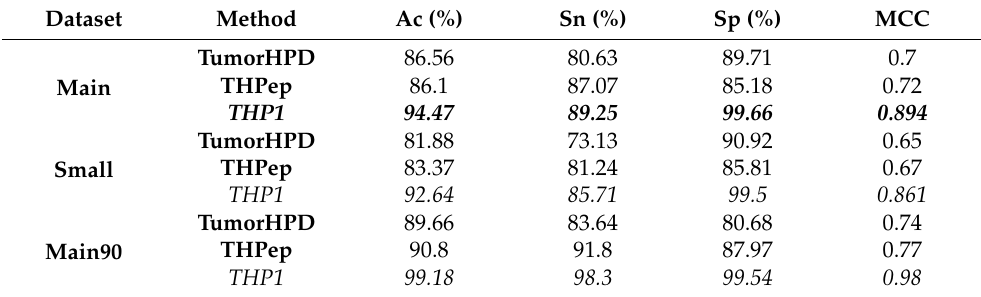
Figure 8. Ranking scores obtained in the Friedman Test. Friedman statistic (distributed according to chi-square with 2 degrees of freedom): 11.166667. P-value computed by Friedman Test: 0.00376. Table 5. Comparison between the best SSM THP1 and the state-of-the-art ML model to predict tumor-homing activity of benchmarking datasets.